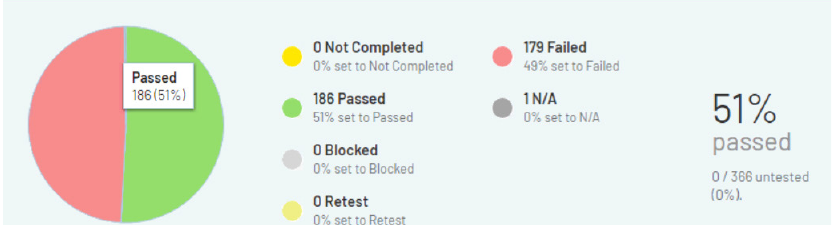
Fig. 2. Jenkins results displayed in test rail